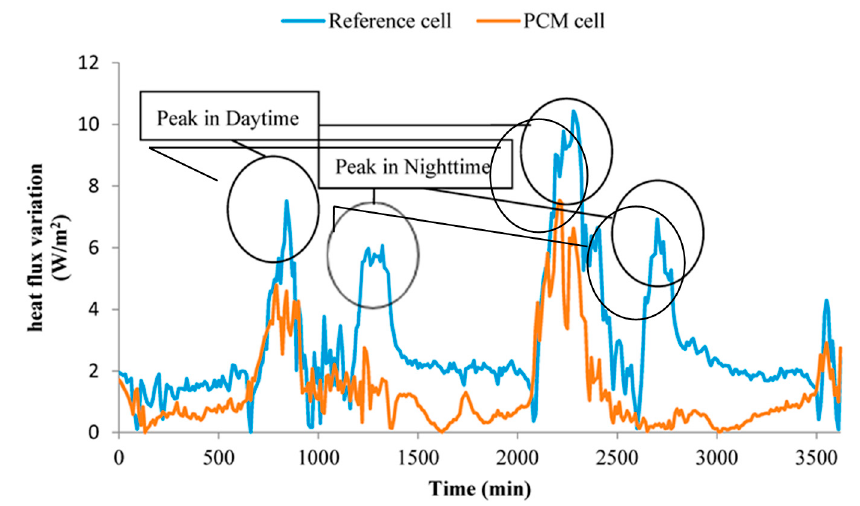
Figure 15. Heat flux variations of PCM cell and reference cell during test period. Table 9. Comparison of detailed thermal data for PCM and reference cells during 48 h.